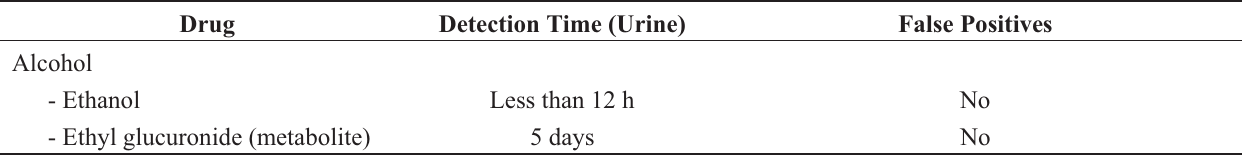
Table 1. Detection time windows and false positives for commonly used